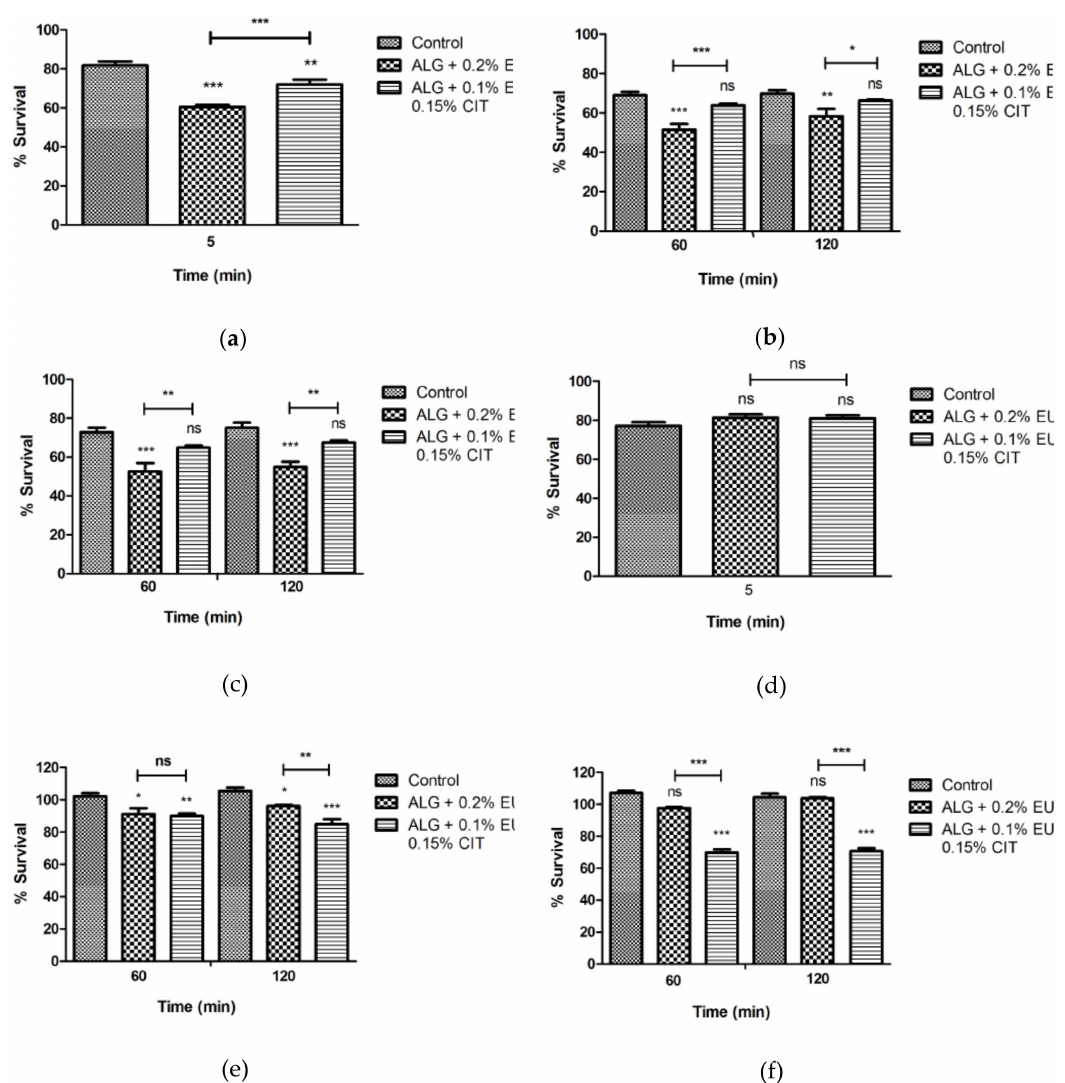
Figure 1. Survival of Listeria monocytogenes 12.04 ( A – C ) and Salmonella enterica serovar Typhimurium ( D – F ) inoculated in edible coating apples (apples prior to the gastrointestinal challenge were maintained at 4 ◦ C for 24 h) during exposure to simulated gastrointestinal system ( A , D -saliva; B , E -gastric fluid (pH 2.5); C , F -intestinal fluid and bile). Data are the mean of three independent experiments. Error bars represent the standard deviation. Significant survival differences * p < 0.05, ** p < 0.01, *** p < 0.001, ns, not significant. The bars show significant differences between the edible coatings. ALG-Alginate, EUG-Eugenol,